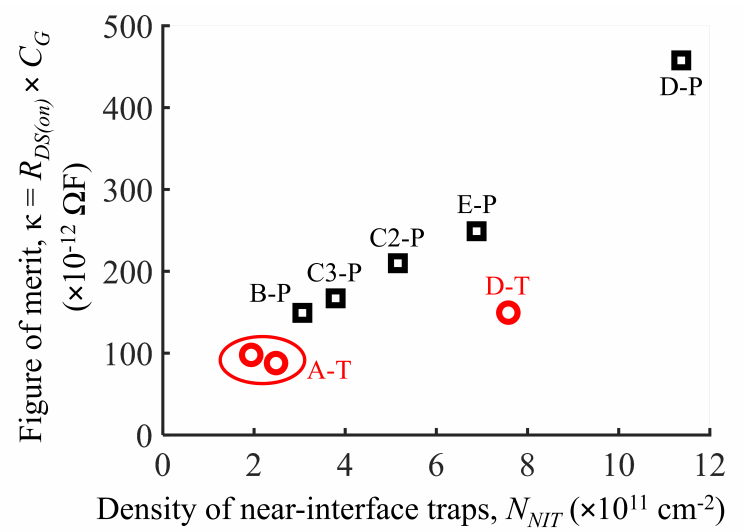
Figure 3. Comparison of 1200 V commercial power MOSFETs listed in Table 1 using the density of near-interface traps ( N NIT ) and the corresponding figure of merit ( κ